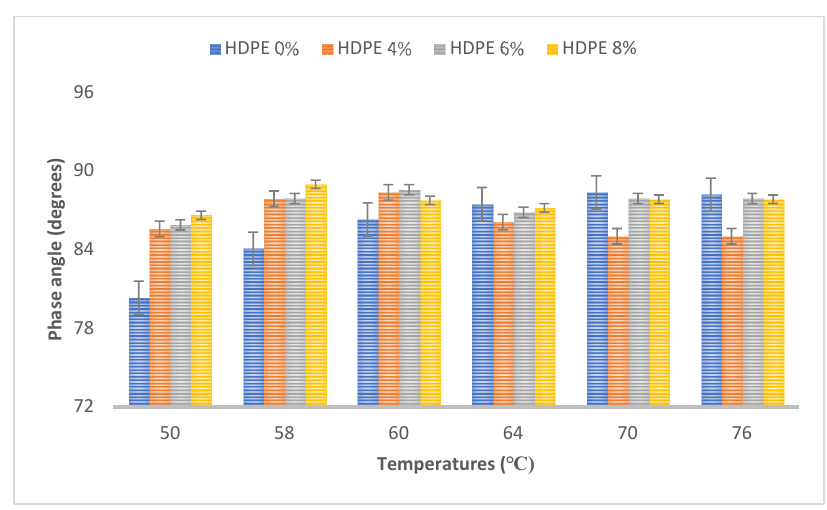
Figure 12. Phase angle results of the HDPE-modified bitumen.